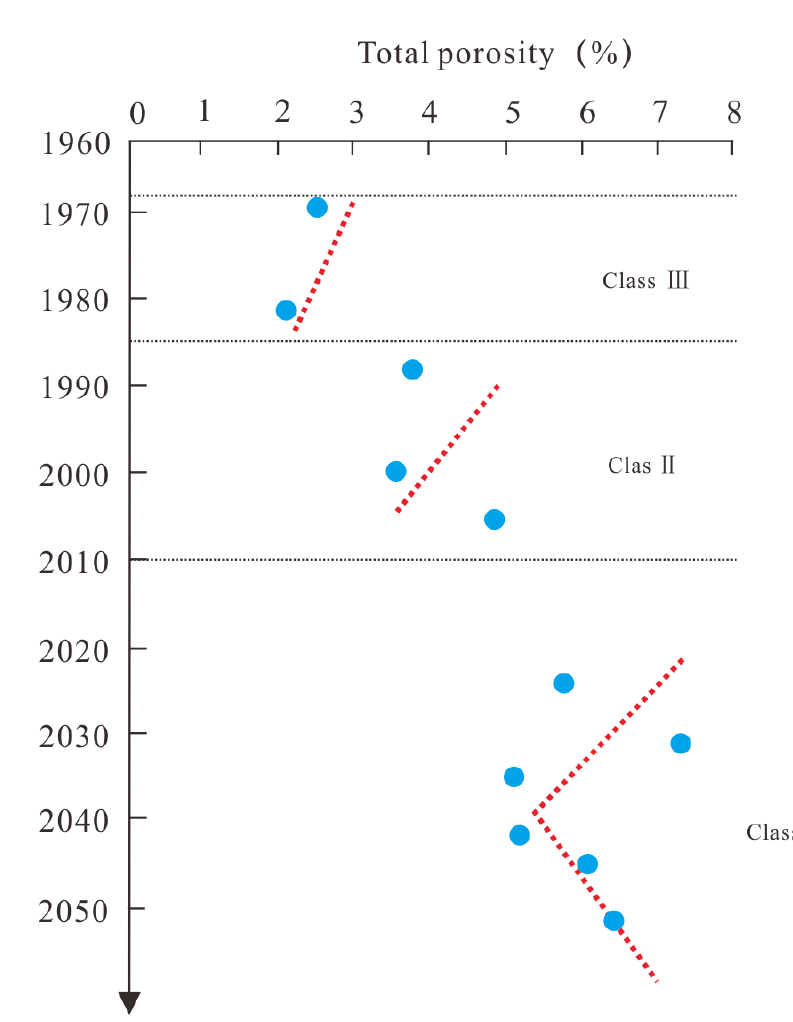
Figure 9. Relationships between total porosity and depth of different types of reservoirs in Da’an area, southern Songliao Basin.